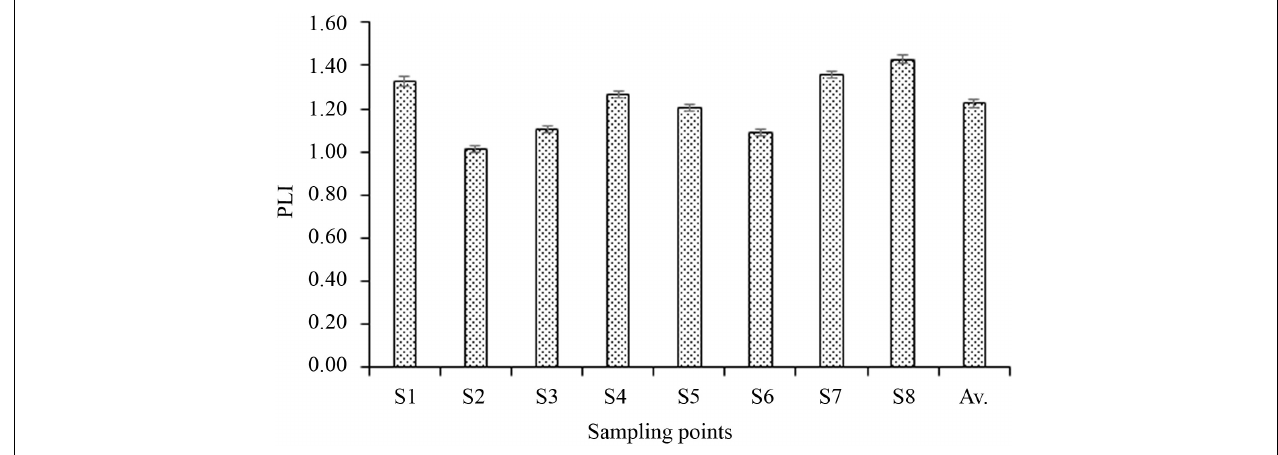
FIGURE 7 | PLI value of each sampling site in beach sediments of Kuakata,